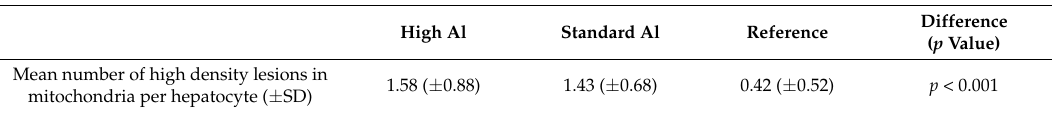
Figure 6. Total serum bile acids: High vs. Low Al.